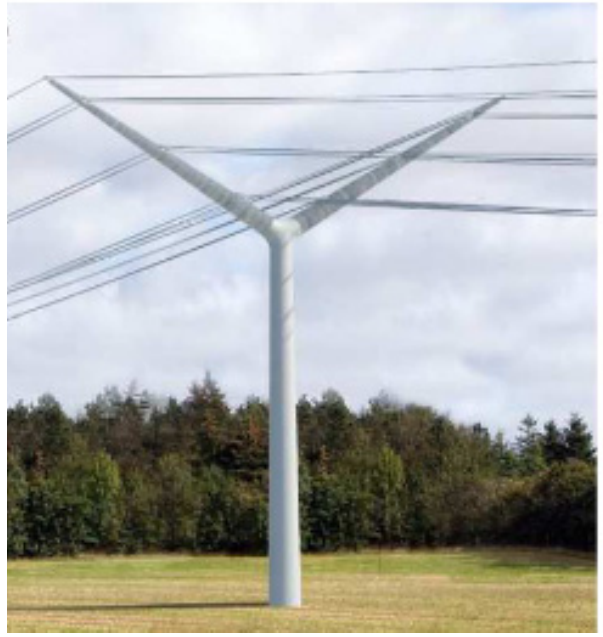
Figure 22. Y ‐ shaped composite pylon overhead line tower [71]. Figure 22. Y-shaped composite pylon overhead line tower [71].